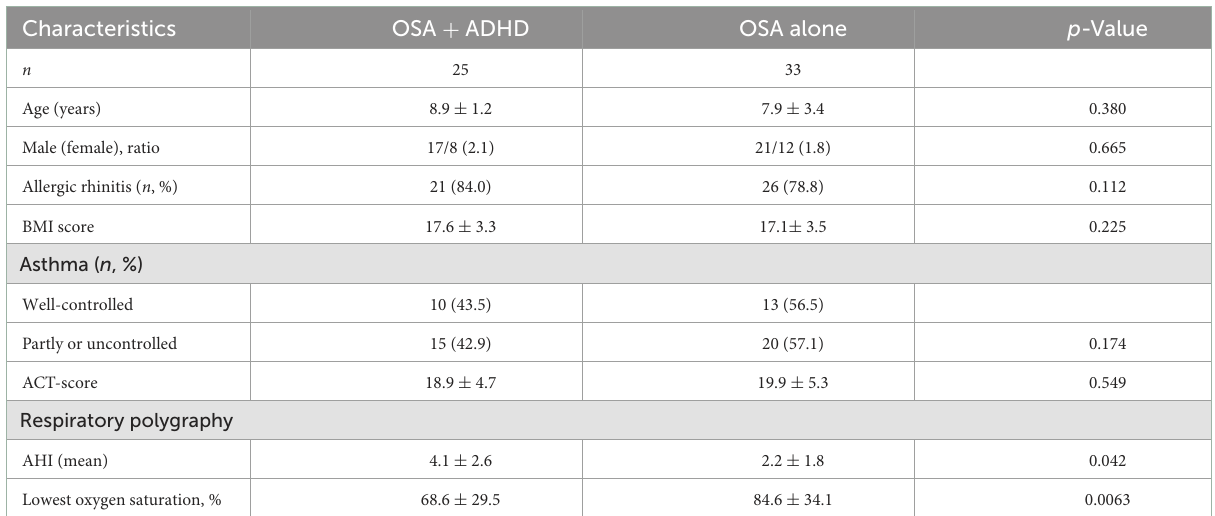
TABLE 5 Demographic characteristics, asthma control, and respiratory polygraphy of the study subjects classified by parent-reported ADHD symptoms. Characteristics OSA + ADHD OSA alone p